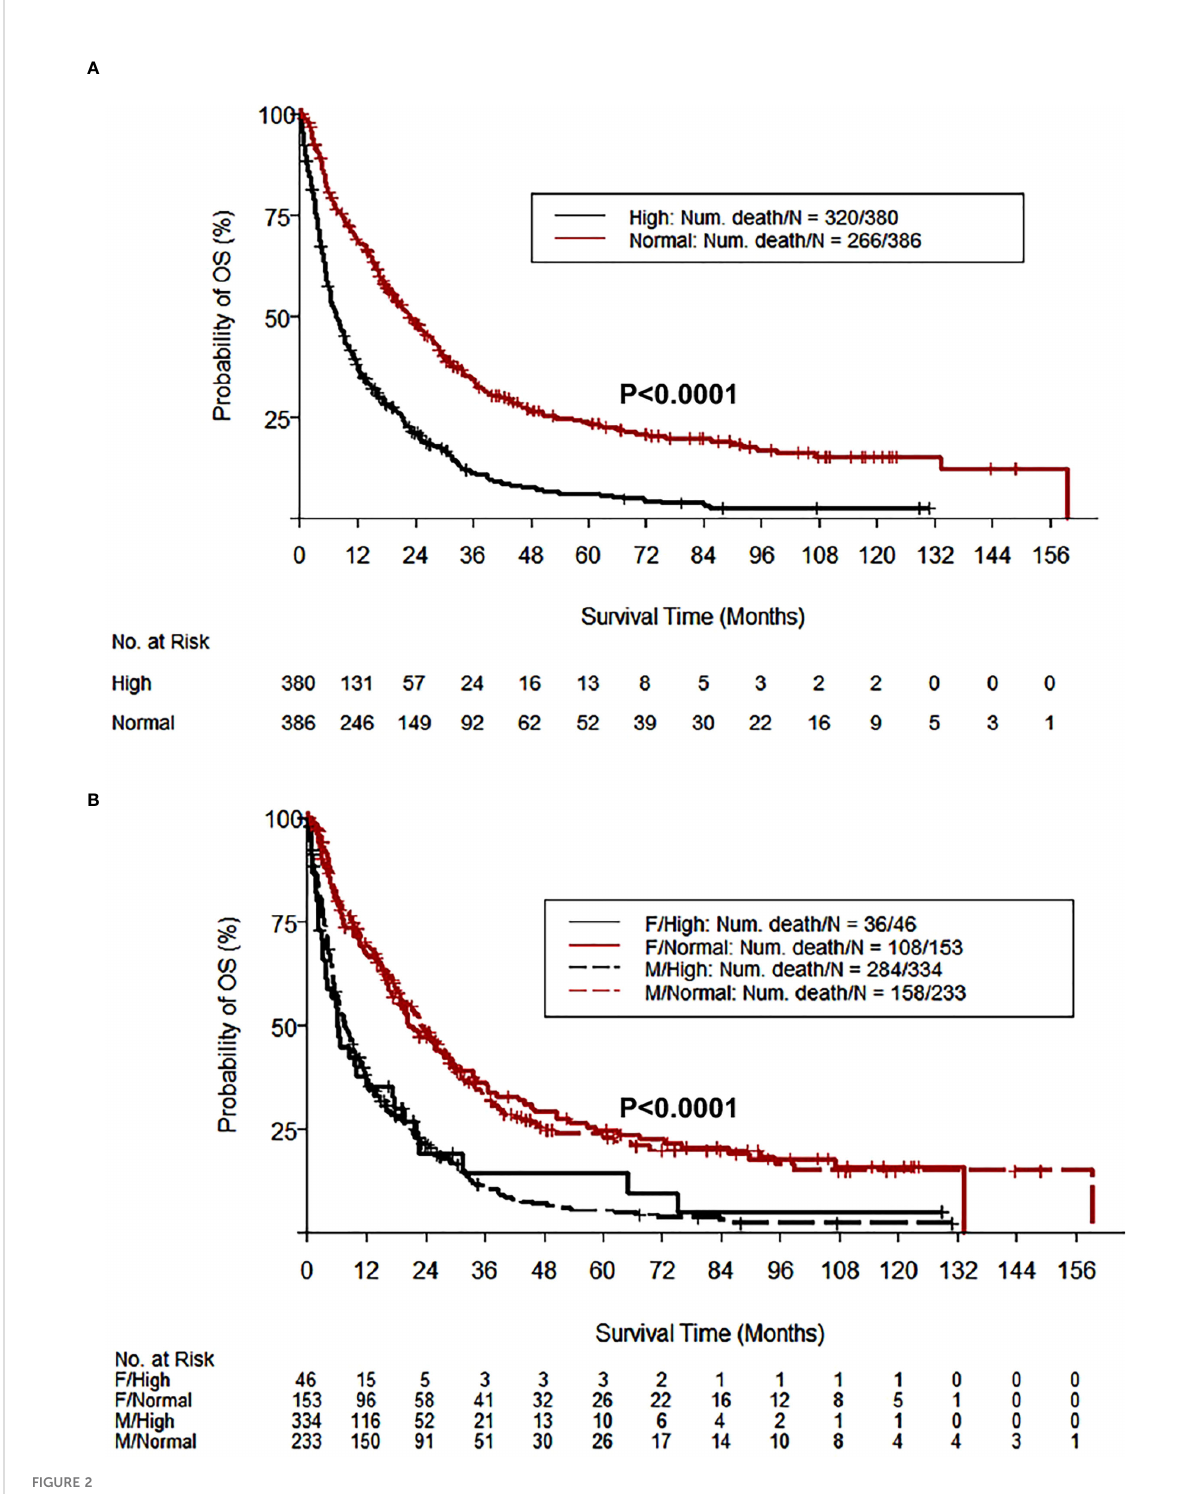
FIGURE 2 HCC patients with high GH levels have shorter OS. The Kaplan-Meier curves of OS according to GH levels demonstrate that 49.5% of HCC patients (380/767) with high GH levels (>0.97 and >3.7 µg/L in males and females, respectively) had a signi fi cantly shorter OS compared with patients with normal GH levels (P<0.0001) (A) . The shorter OS survival in HCC patients with high GH levels was gender-independent (B)